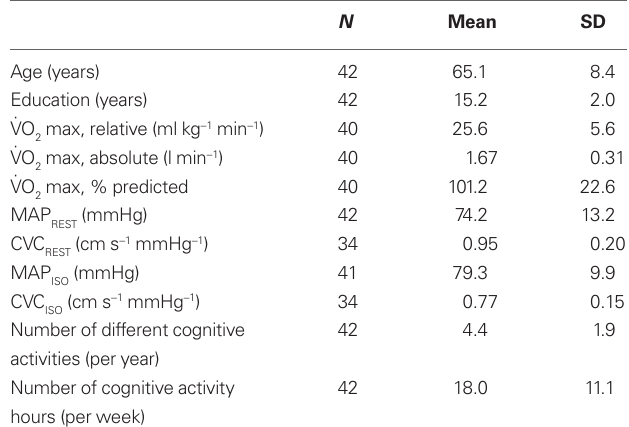
Table 1 | Characteristics of